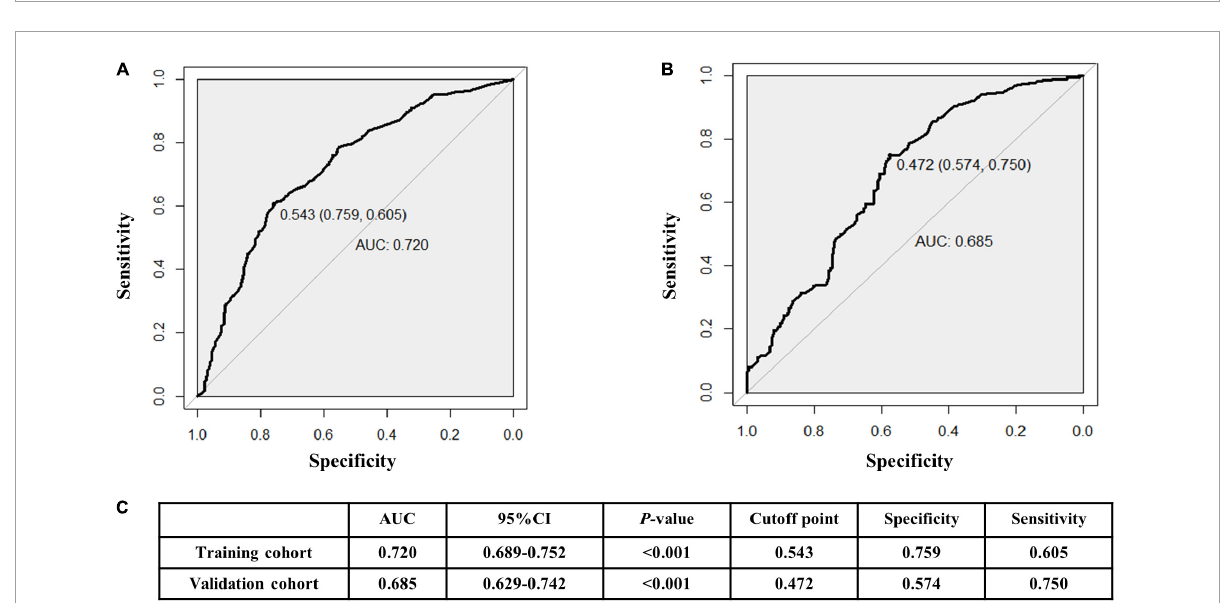
FIGURE9 Receiver operating characteristic (ROC) curves for the female training (A) and validation (B) cohorts. (C) illustrates some of the results of the ROC curve for the training and validation